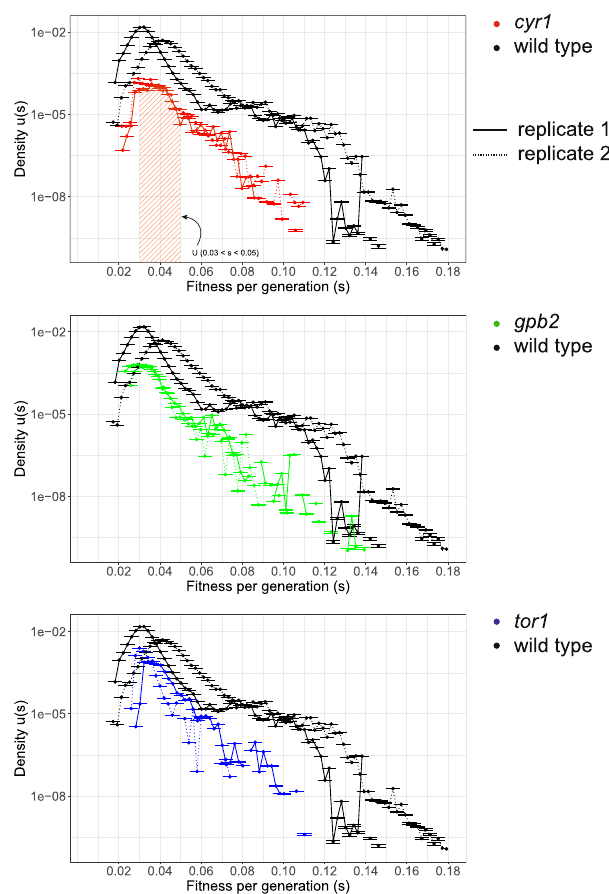
Fig. 2 Mutation rates and fi tness effects are smaller during the 2nd-step evolutions, as compared to the 1st-step. Mutation rates per fi tness bin were calculated for all 2nd-step evolutions and compared to the 1st-step (wild type). The integration of the area below the probability density curve represents mutation rate at the respective fi tness interval. For instance, the shaded area in the top panel represents the mutation rate to generate mutants with a fi tness value between 0.03 and 0.05. The complete wild- type evolution datasets were taken into account for the calculation (see Supplementary Fig. 5). The Y -axis error is de fi ned in Eq. (2) and the error bars de fi ne the mutation rate ± the error (most error bars are suf fi ciently small so that the upper and lower handle appear to overlap). For a more direct comparison of all genotypes in a single plot see Supplementary Fig.